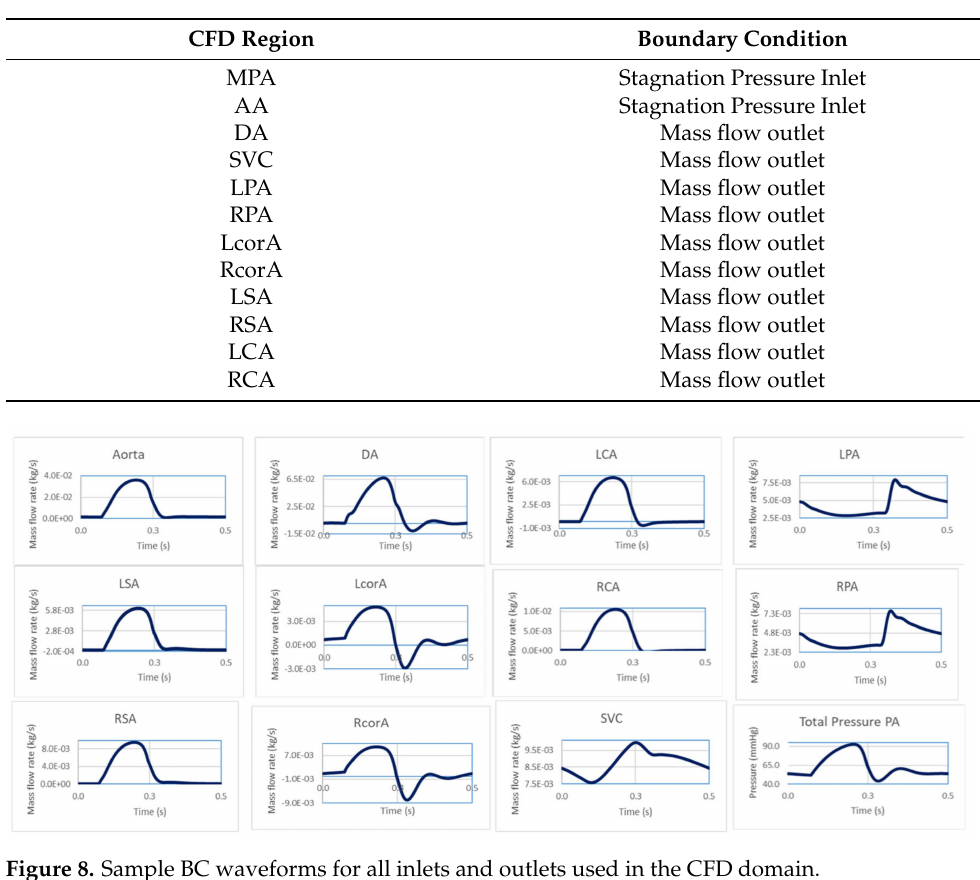
Table 2. Describes the various types of boundary conditions imposed for each CFD region.